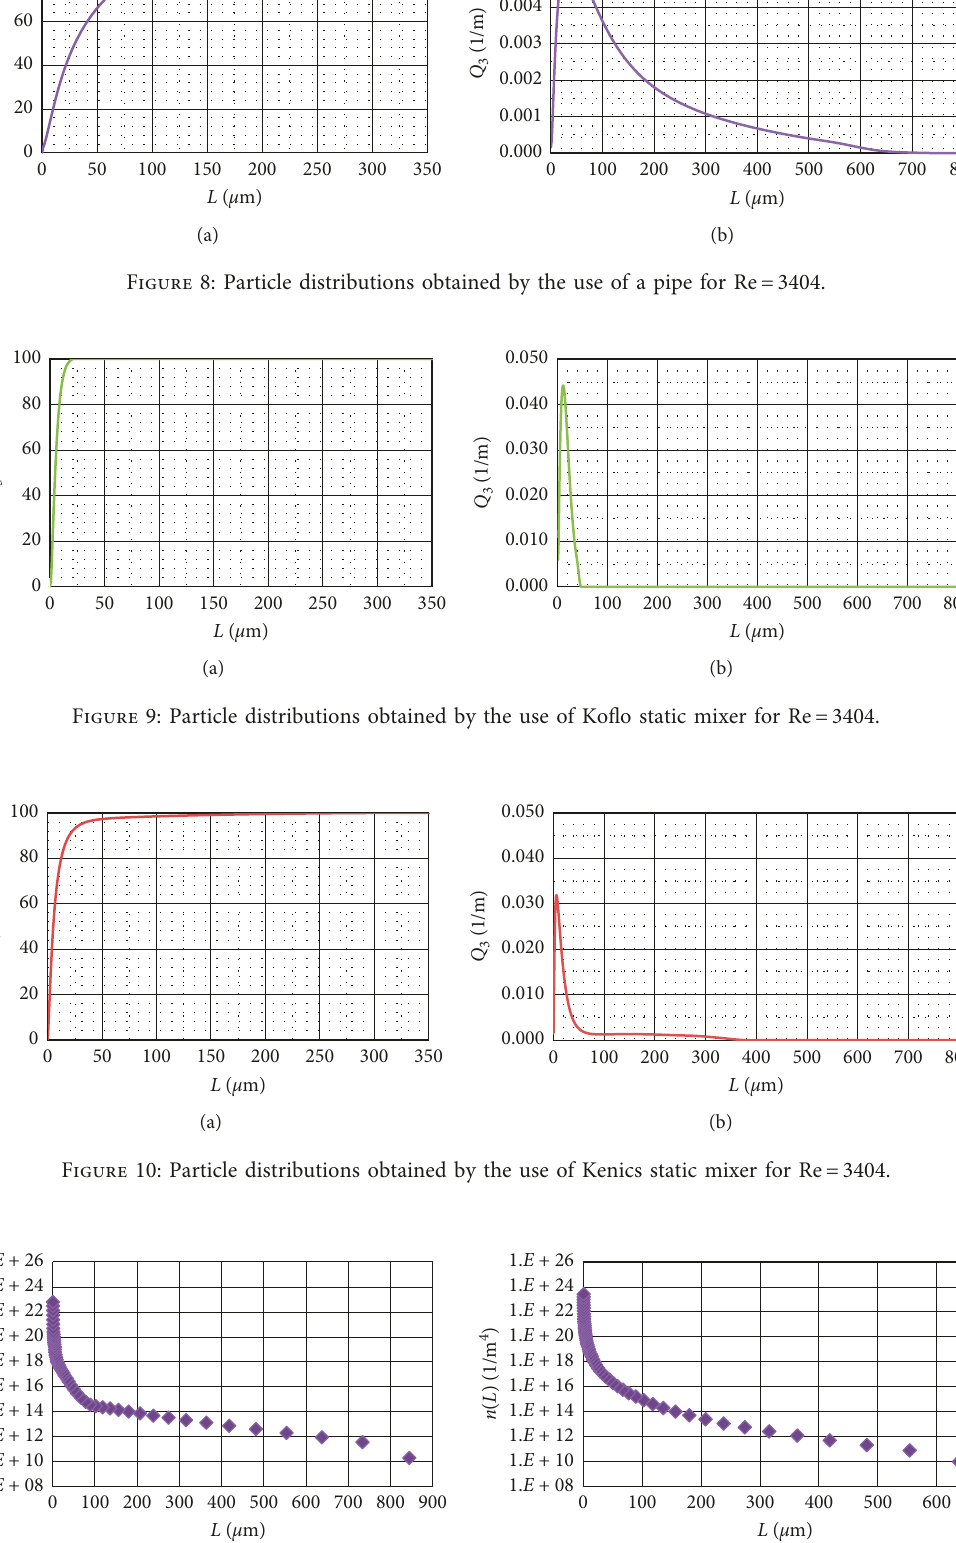
L obtained by the use of a pipe: (a) Re ( )